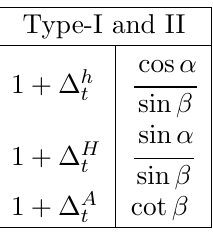
Table 1 . Top quark Yukawa couplings to the light (heavy) CP-even and CP-odd Higgs bosons. These are identical for type-I and type-II 2HDM.